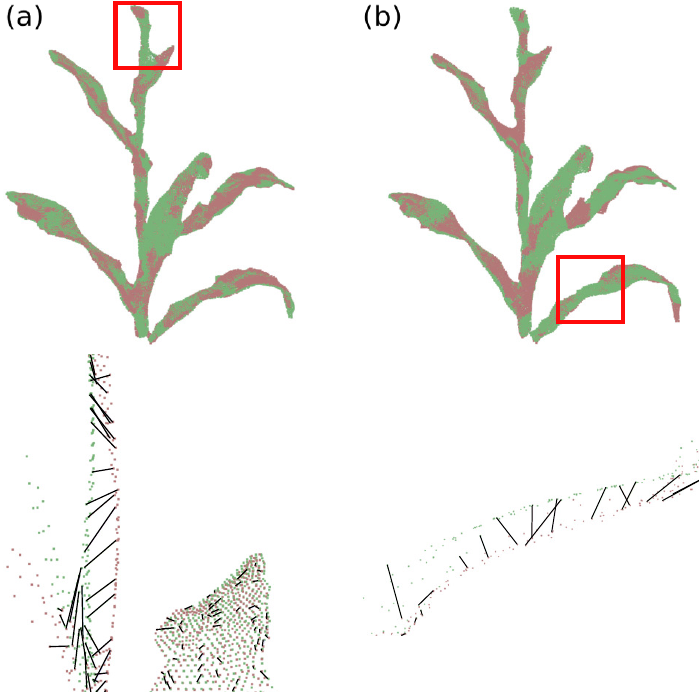
Figure 10. Keypoints correspondence. ( a ) Plant’s stem region, comparison of deformation graphs between frames 30 (green) and 40 (red) and ( b ) plant’s leaf region, comparison of deformation graphs between frames 40 (green) and 50